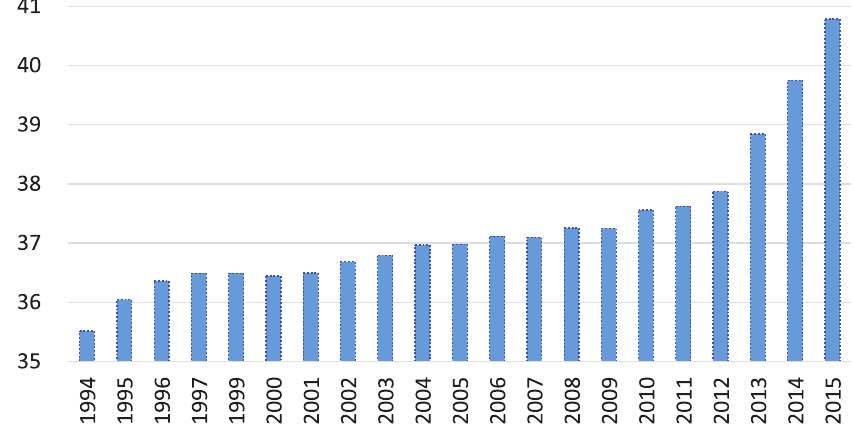
Figure 2. Percentage of women employed in state-owned enterprises: China 1994–2015. Source: Calculated from NSB (2016b, Tables 1–17 and 1–23).